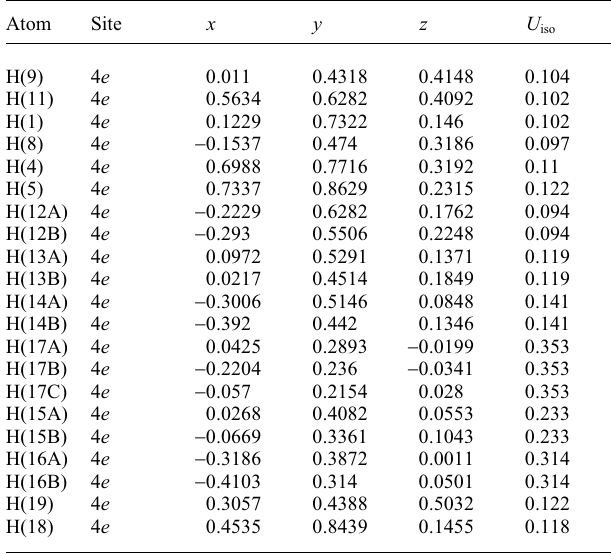
Table 2. Atomic coordinates and displacement parameters (in Å 2 ) .